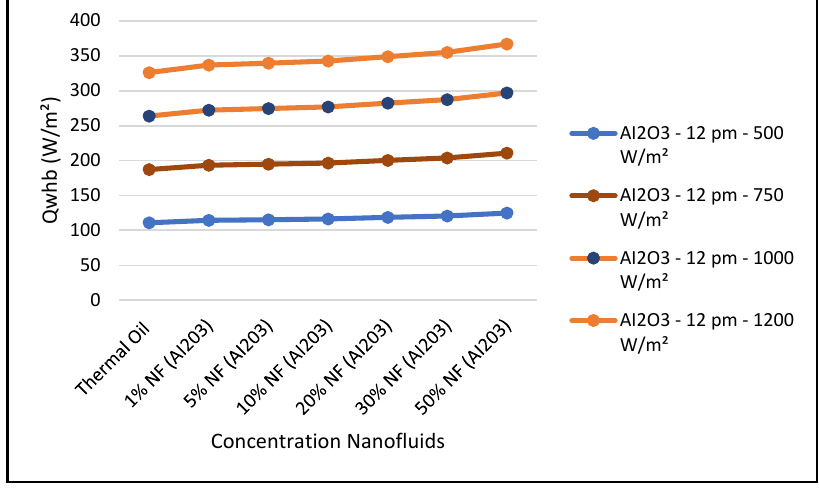
Figure 22. ORC waste heat boiler thermal energy at different concentrations of Al 2 O 3 .